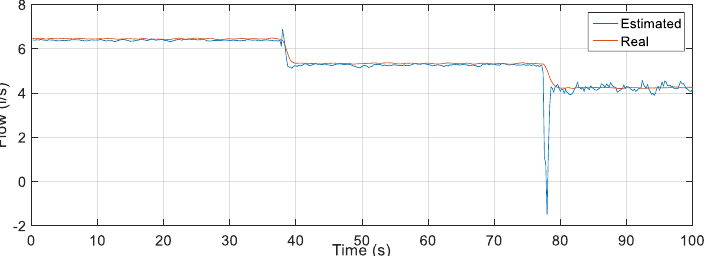
Figure 13. Measurement and estimation of flow during ANN testing using Multi-layer Feedforward Backpropagation.